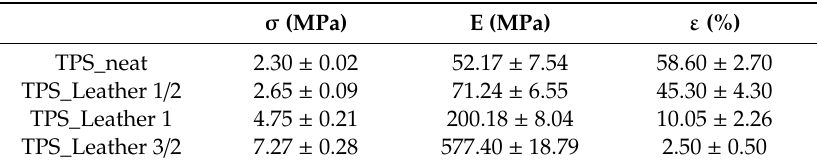
Table 2. Summary of tensile test